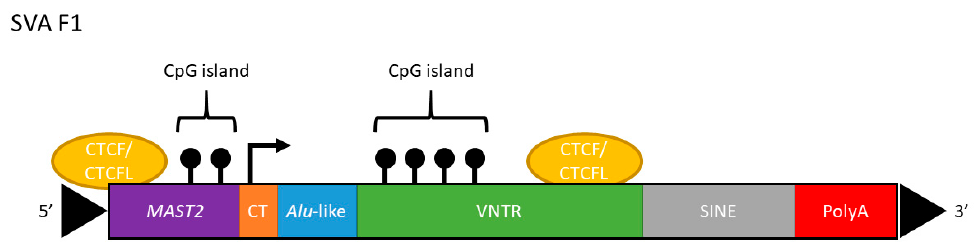
Figure 1. The canonical structure of the SVA F1 retrotransposon subclass, 5 (cid:48) to 3 (cid:48) displayed left to right. Purple: 5 (cid:48) transduction of exon 1 of MAST2 . Potential CCCTC-binding factor (CTCF) binding site and CpG island are displayed. Orange: The (CCCTCT)n hexamer repeat, which may be variable in copy number. Note, much of this sequence has been replaced by the MAST2 transduction. Blue: The Alu -like region, which is composed of two antisense Alu regions separated by a small intervening sequence. Green: The VNTR region which may be one or two regions of 35–50 bp tandem repeats, and may reach GC content of 70%. A CpG island is pictured, with black lollipops signifying 5-methylcytosine residues. A potential binding site for CTCF is shown. Grey: The SINE region is derived from the 3 (cid:48) LTR of the retroviral HERV-K10 element. Red: The canonical polyadenylated tail can act as a signal for transcription termination but may be bypassed by RNA polymerase, and is thought to be important for SVA retrotransposition. Black arrowheads indicate target site duplication regions resulting from insertion.